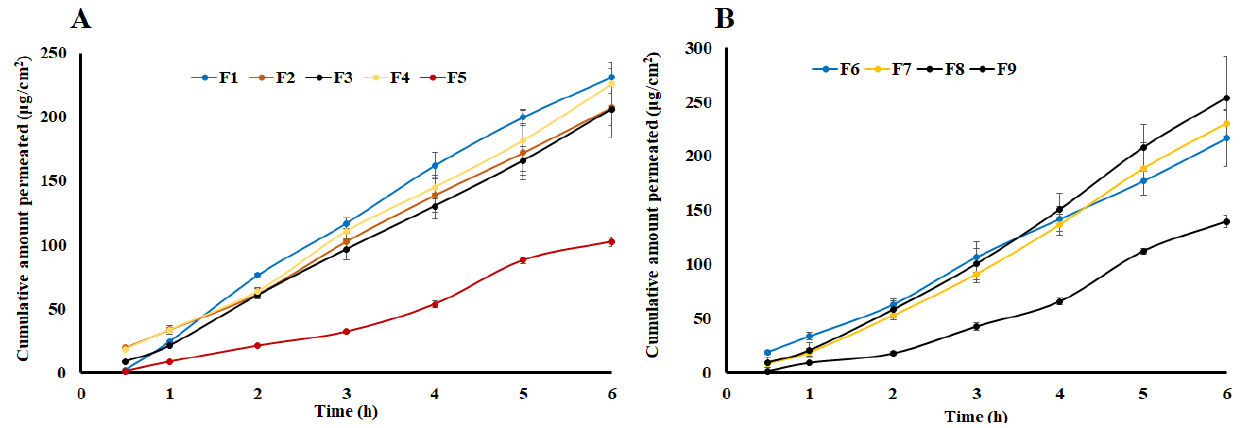
Figure 5. ( A ) Permeation of transdermal gel formulations F1, F2, F3, F4, and F5 through Strat-M ® . ( B ) Permeation of transdermal gel formulations F6, F7, F8, and F9 through Strat-M ® . Data are shown as mean ± SD, n = 6.